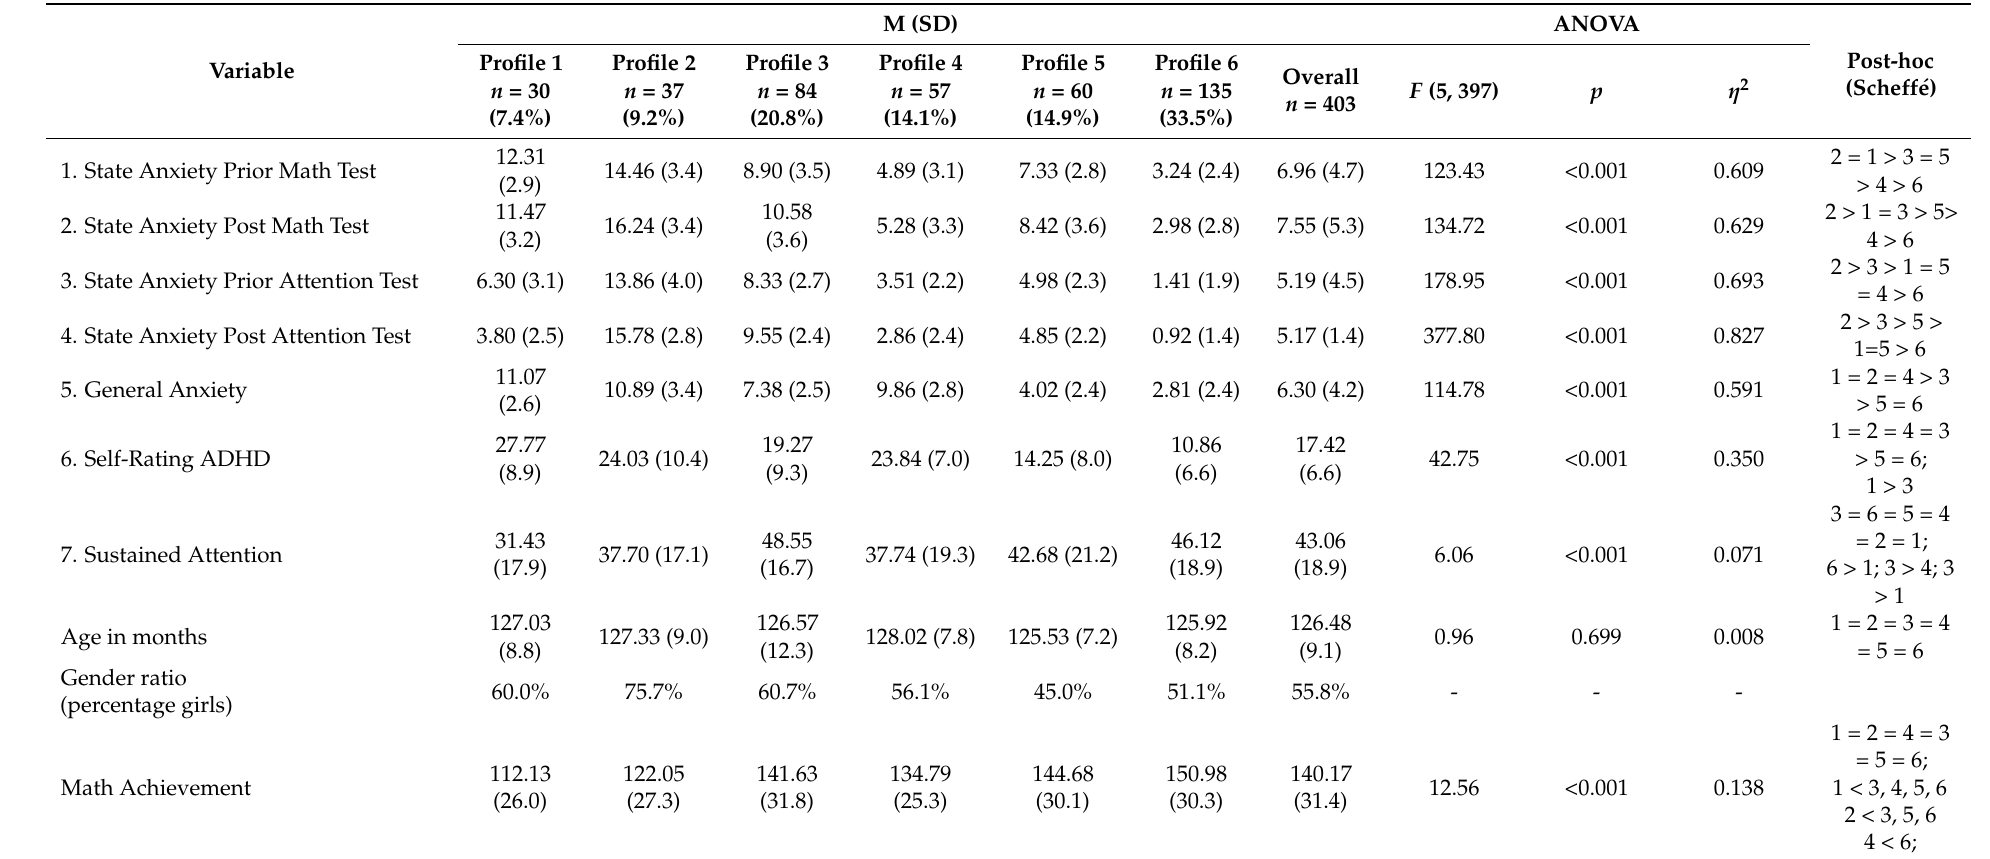
Table 5. Model fit indices for latent profile